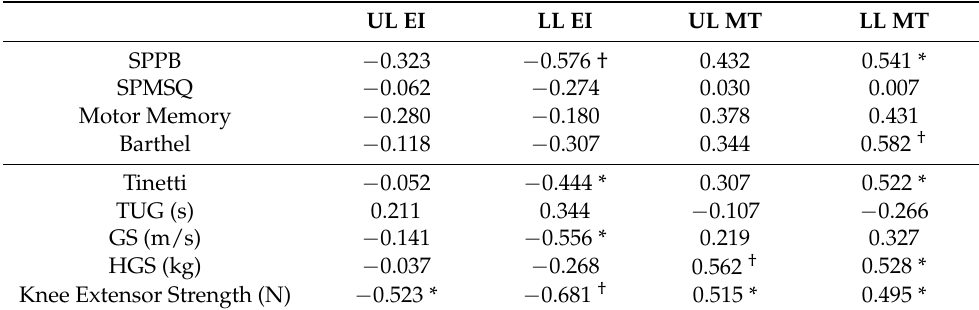
Table 2. Pearson’s product–moment correlation coefficient between cognitive and physical variables and ultrasonography variables.